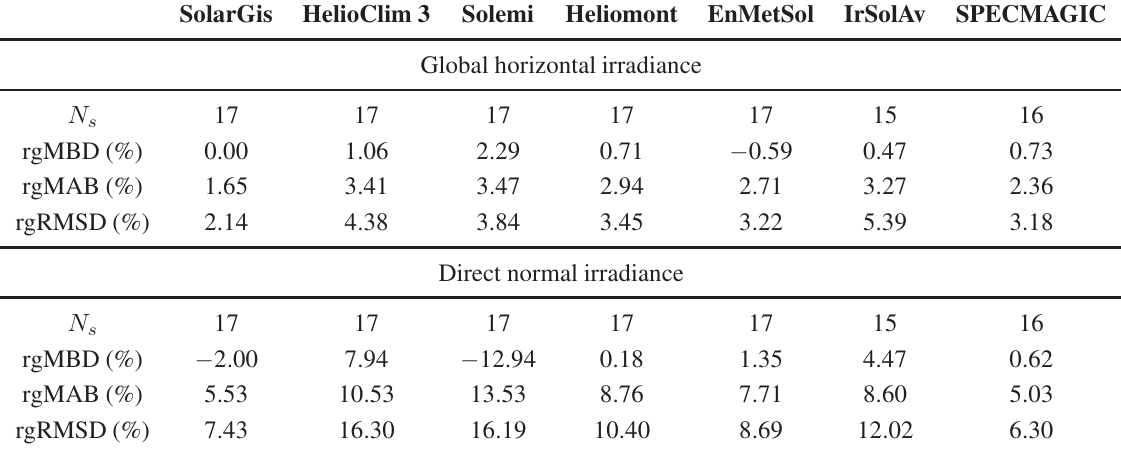
Table 9. General statistics for the validation of global horizontal and direct normal irradiance estimation, Ineichen, 2013 [36]. The results for the present work are given as the last column for comparison. SolarGis HelioClim 3 Solemi Heliomont EnMetSol